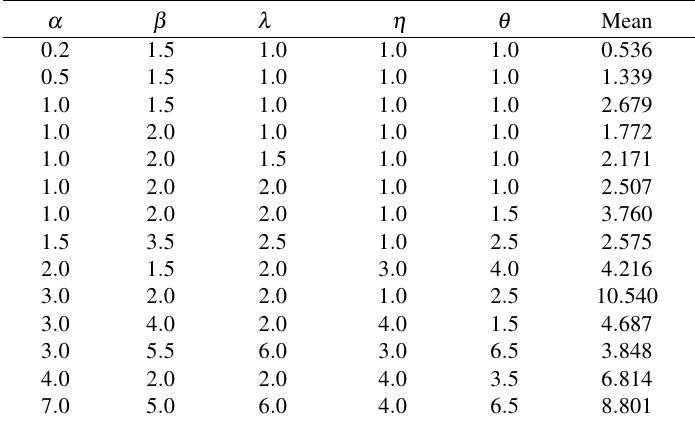
Table 1. Mean of the EKIW distribution for different values of the